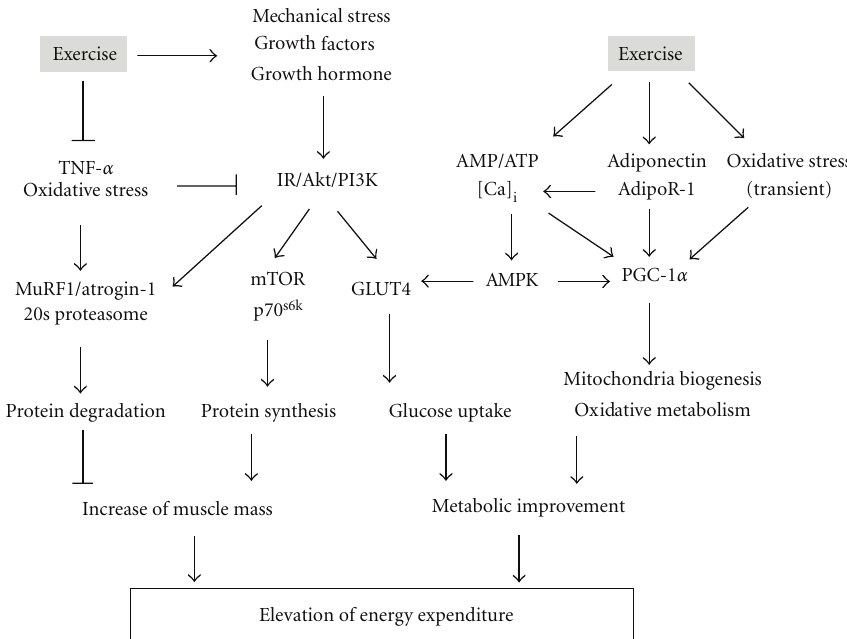
Figure 2: Molecular mechanism of muscle metabolic improvement due to